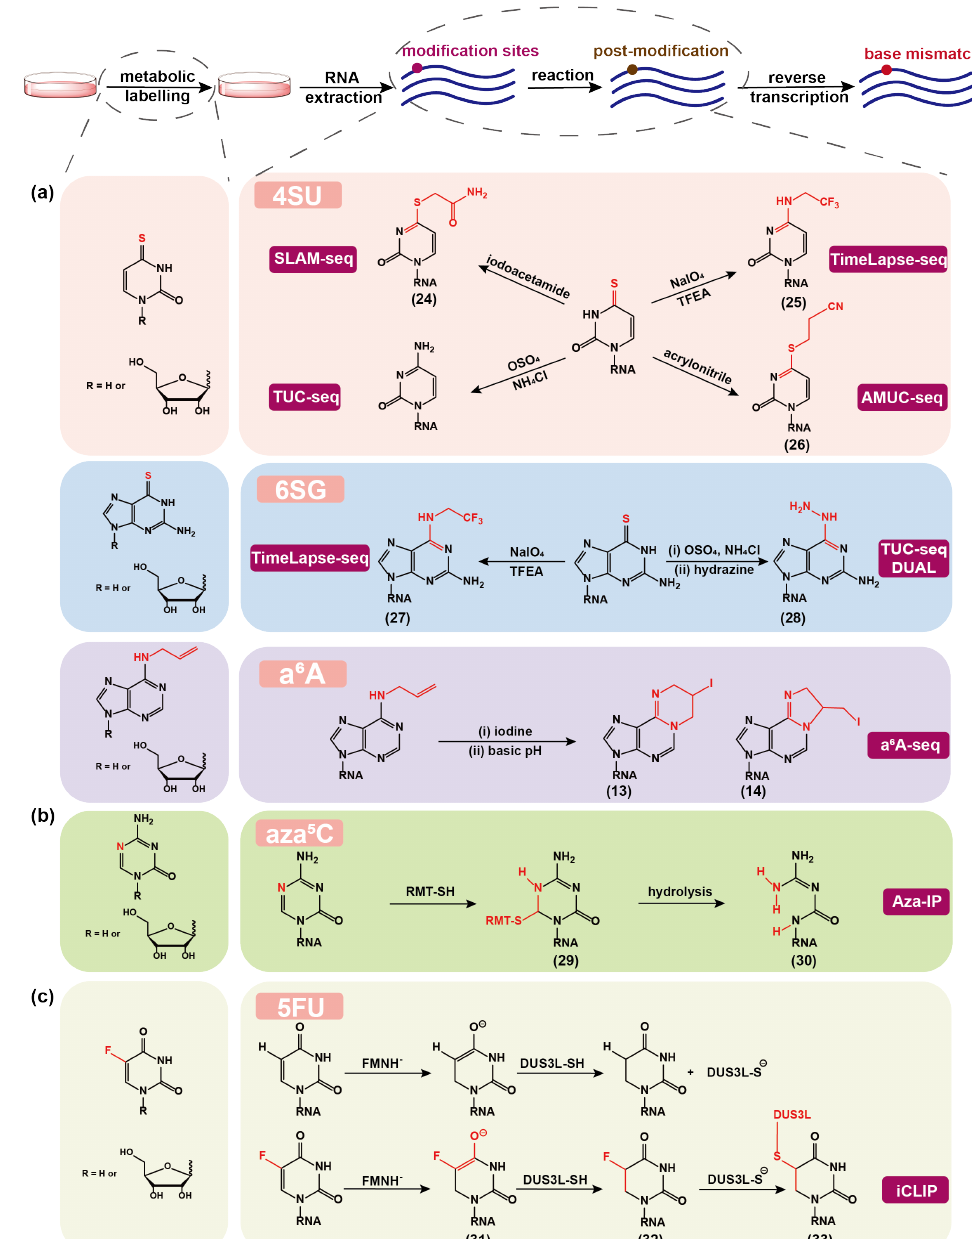
Figure 3. The nucleoside analogs and amino acid derivatives used for metabolic labeling of RNA and the associated chemical or enzymatic reactions for converting metabolically labeled nucleoside analogs into post-modified forms, which can mostly induce base mismatch during reverse transcrip- tion of RNA into cDNA and thus can be identified at single base resolution in the corresponding high-throughput sequencing methods. ( a ) The chemical rationales for profiling cellular RNA dynam- ics. ( b ) The chemical rationales for determining natural RNA modifications. ( c ) An enzymatic post- modification, which induces truncation instead of base mismatch during reverse transcription of RNA into cDNA, is shown as a comparison. SLAM-seq: thiol(SH)-linked alkylation metabolic sequenc- ing; TUC-seq: thiouridine-to-cytidine conversion sequencing; AMUC-seq: acrylonitrile-mediated uridine-to-cytidine conversion sequencing; Aza-IP: 5-azacytidine–mediated RNA immunoprecipi- tation; iCLIP: individual-nucleotide resolution UV cross-linking and immunoprecipitation; TFEA: 2,2,2-trifluoroethylamine; RMT: m 5 C-RNA methyltransferases; FMN: flavin mononucleotide; DUS3L: a dihydrouridine synthase